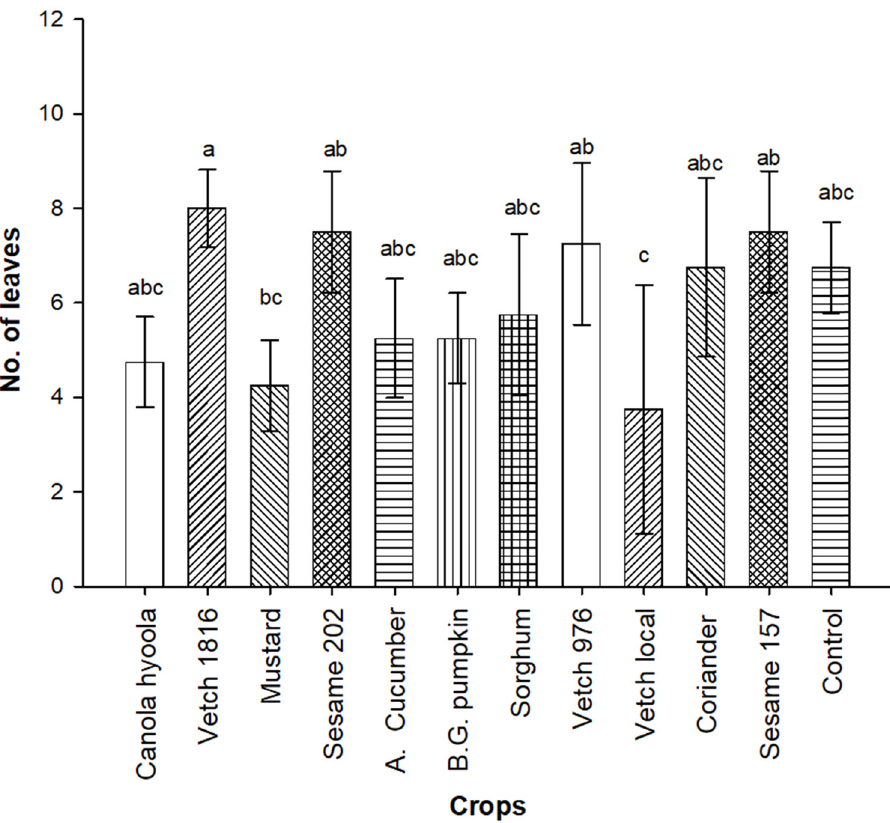
Figure 5: E ff ects of arti fi cial inoculation with Meloidogyne spp. and 11 trap crops on the number of leaves in lettuce plants. The standard deviation of the means is designated by the error bar for each mean. Means followed by the same letter are not signi fi cantly di ff erent ( SNK, P > 0.05 )